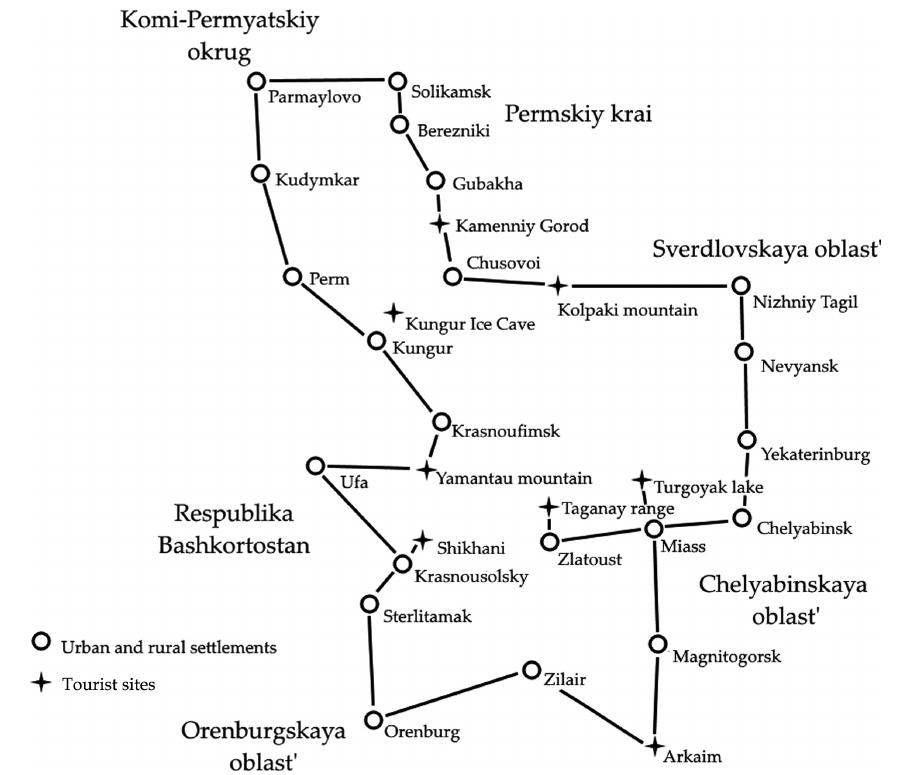
Fig. 1. Interregional tourist route in the Urals – ‘Iron